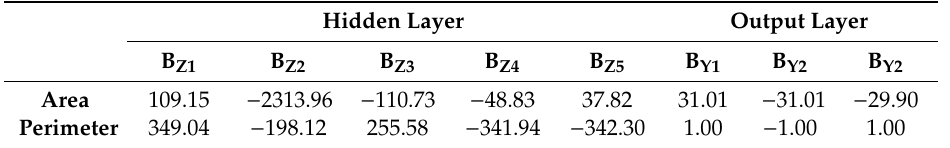
Table 9. Bias for area and perimeter